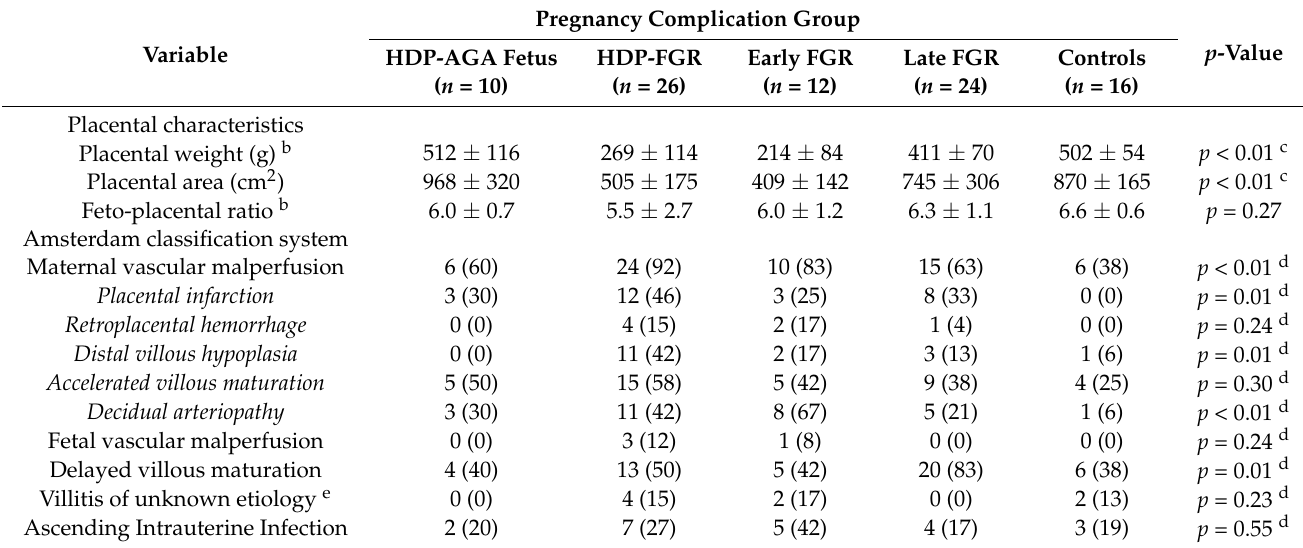
Table 3. Placental characteristics a and Amsterdam classification system of placental injury according to pregnancy complication groups and controls.